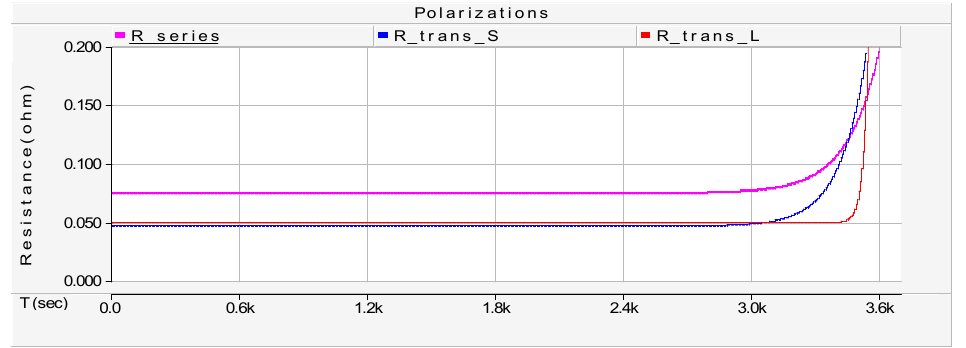
Figure 4. Change of battery polarizations with decrease in SOC along a time axis.